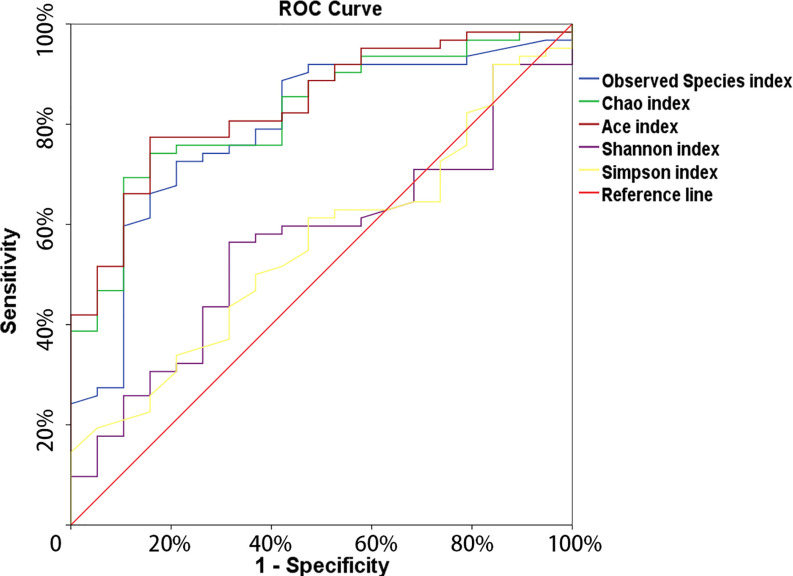
The ROC curve used to analyze the clinical accuracy of using alpha- richness obtained from the bladder-cancer group and non-cancer group for the diagnosis of bladder cancer.